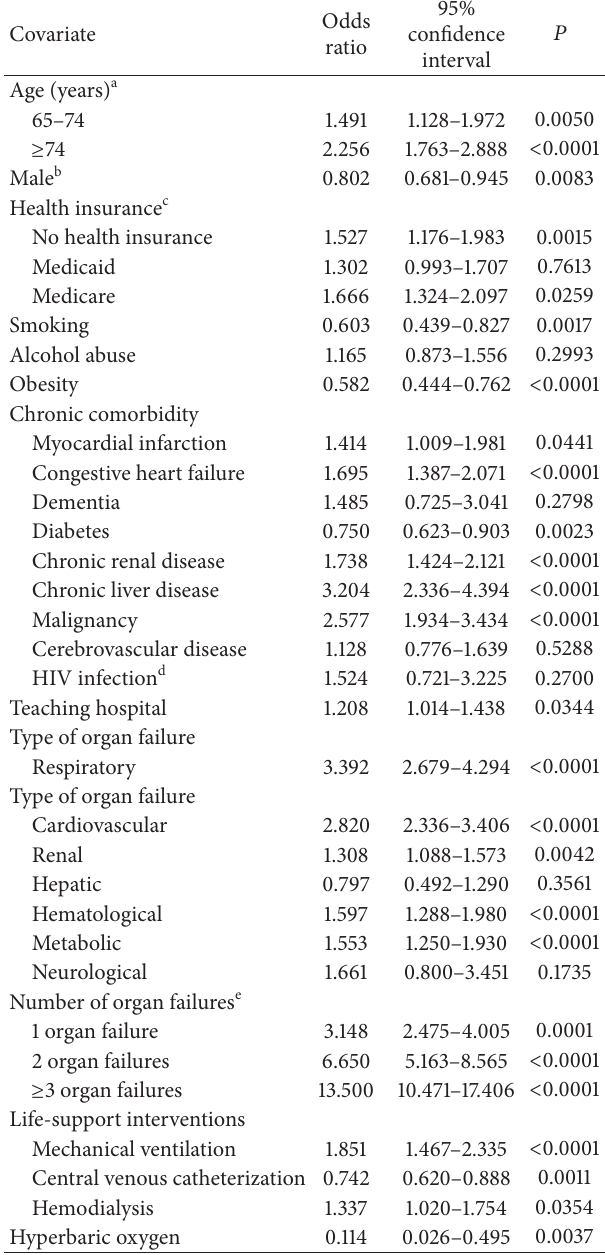
Table 3: Predictors of hospital mortality among hospitalizations with necrotizing